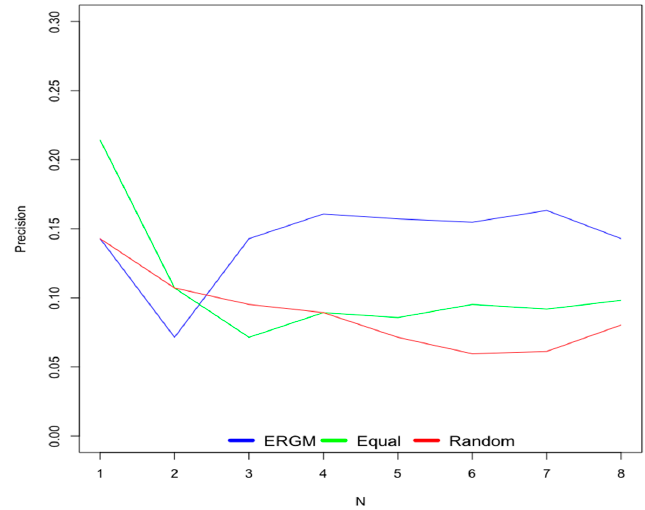
Figure 5. Precision for old users.